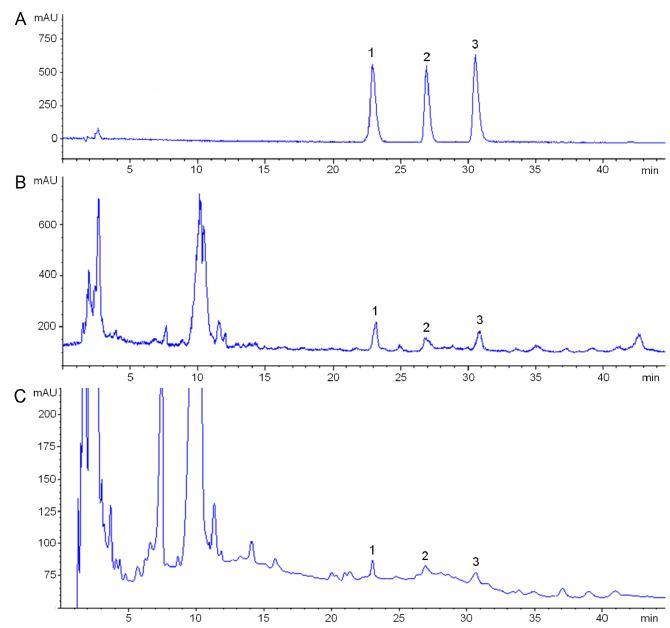
Figure 4. Representative HPLC ‐ ELSD chromatographic profiles of FISA in the bulbs of F. cirrhosa . ( A ) HPLC ‐ ELSD chromatographic profiles of ISA standards. ( B ) HPLC ‐ ELSD chromatographic pro ‐ files of FISA in the bulbs from 3 ‐ year ‐ old F. cirrhosa . ( C ) HPLC ‐ ELSD chromatographic profiles of FISA in the bulbs from 1 ‐ year ‐ old F. cirrhosa bulbs. 1, imperialine; 2, peininine; 3, peimine.